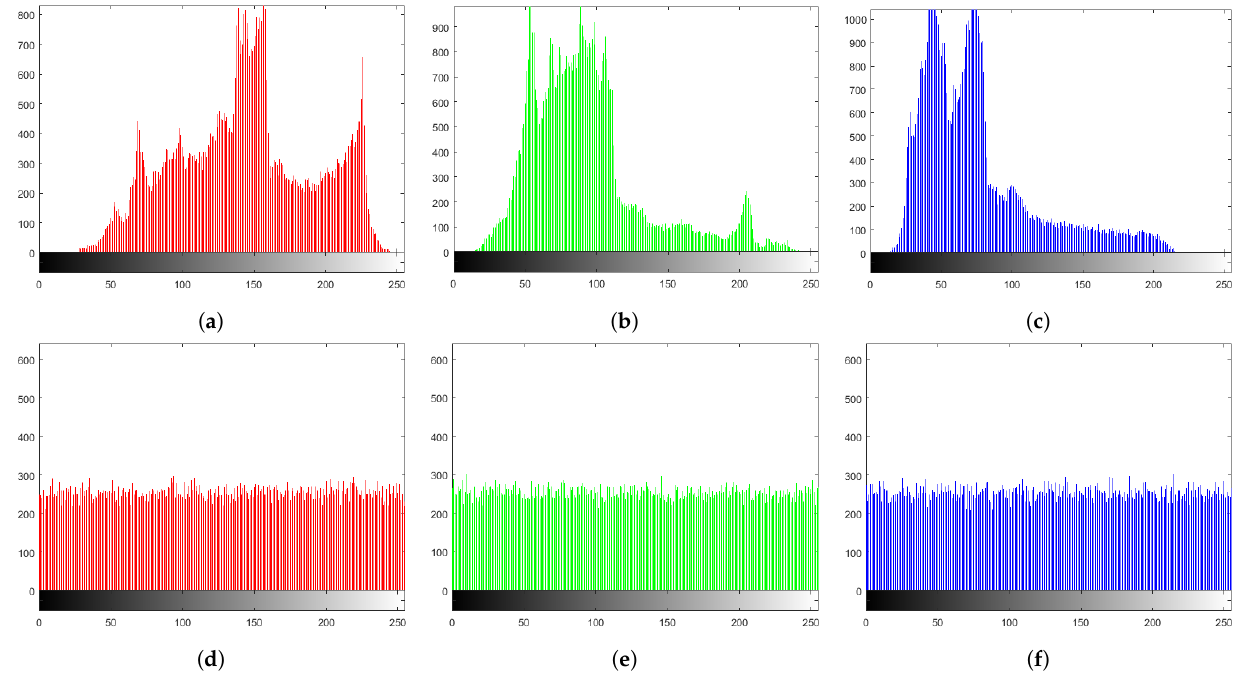
Figure 7. Histograms ( a – f ) for OImg01 and its encrypted version before embedding onto the reference.